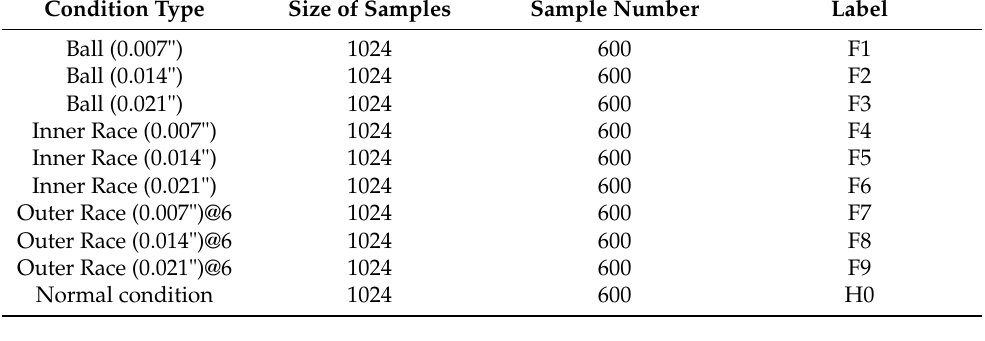
Table 2. Composition of experimental samples.